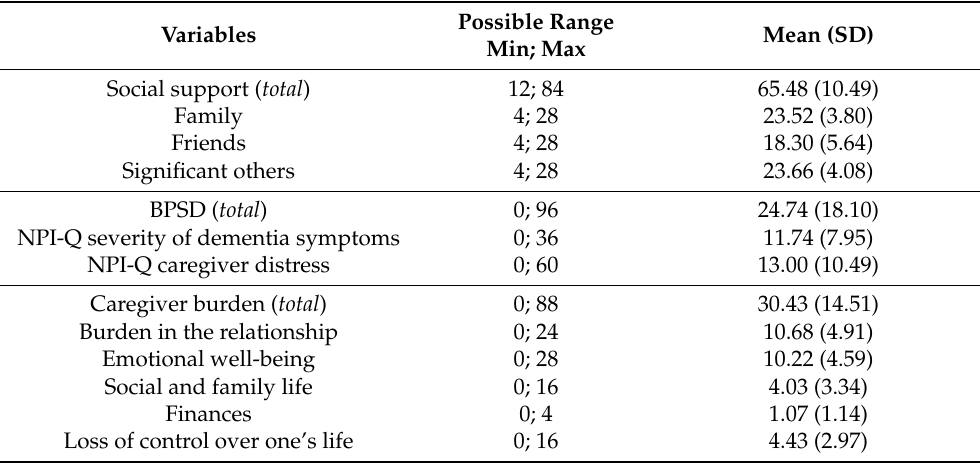
Table 2. Perceived social support, BPSD, and caregiver burden ( n = 207).